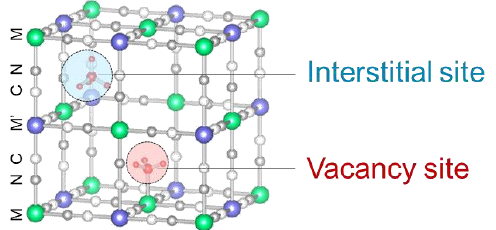
Figure 1. The crystal structure of PBA with a hexacyanoferrate vacancy at the center. The interstitial sites and vacancy sites are exhibited as red and blue balls, respectively.